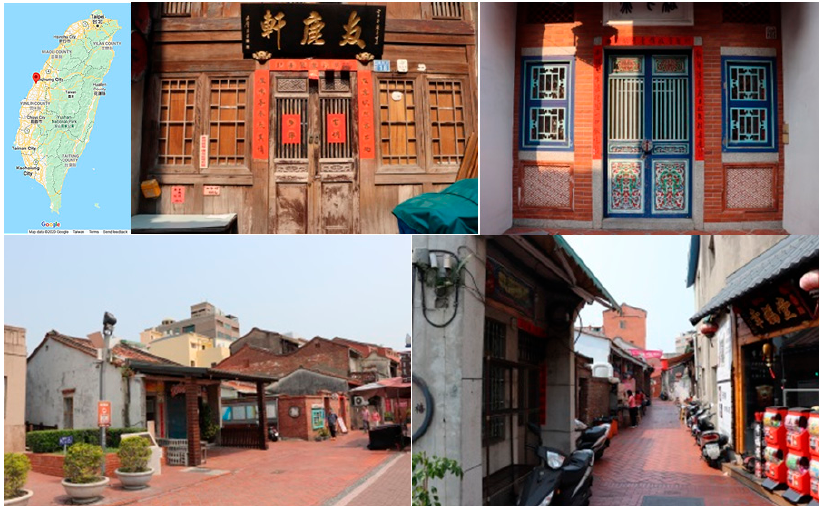
Figure 1. Street scenes of the Old Street in Lukang, Taiwan.